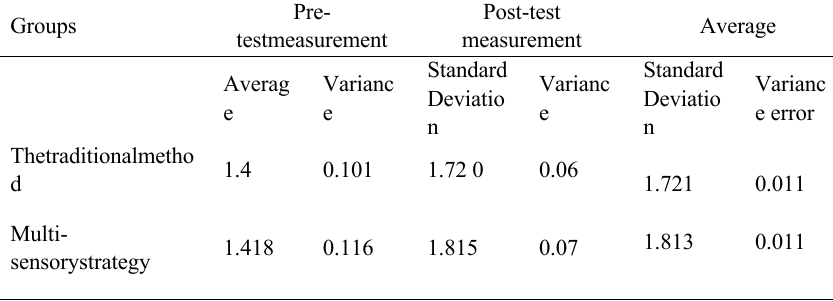
Averages and standard deviations of the experimental and the control groups in pre- test and post-test measurements and averages with standard errors in the post-